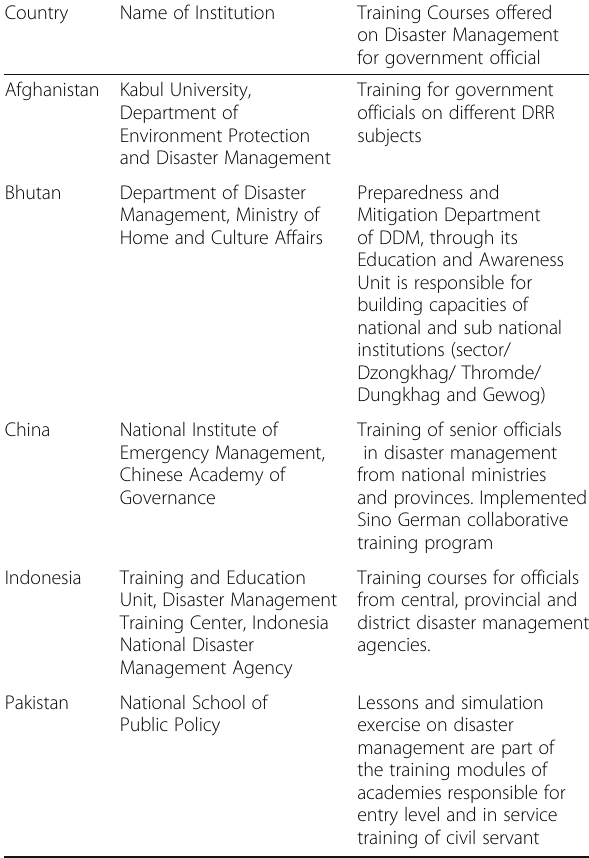
Table 5 Disaster management trainings for the